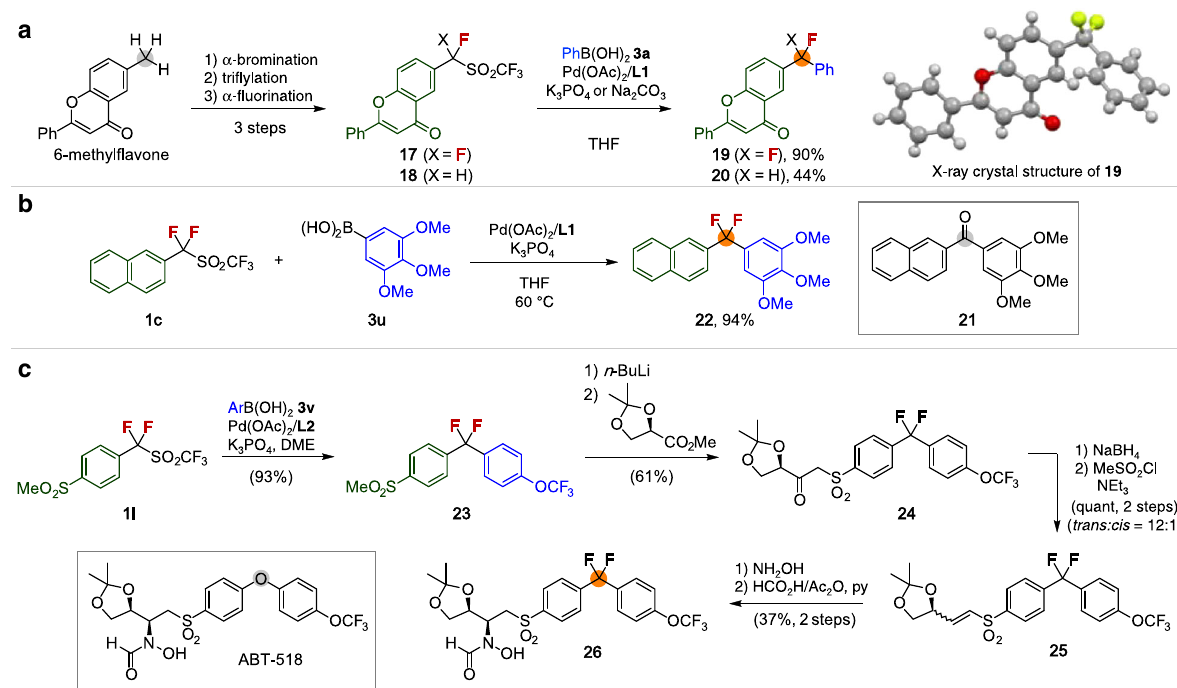
Fig. 6 Synthetic applications. a Sequential transformation of benzylic C – H bond of fl avone derivatives. b Rapid preparation of the analog 22 bearing CF 2 unit as bioisosteres of carbonyl group. c Illustration of desulfonylative cross-coupling in the synthesis of the analog of ABT-518 ( 26) in which the diarylether unit is replaced by a diarylCF 2